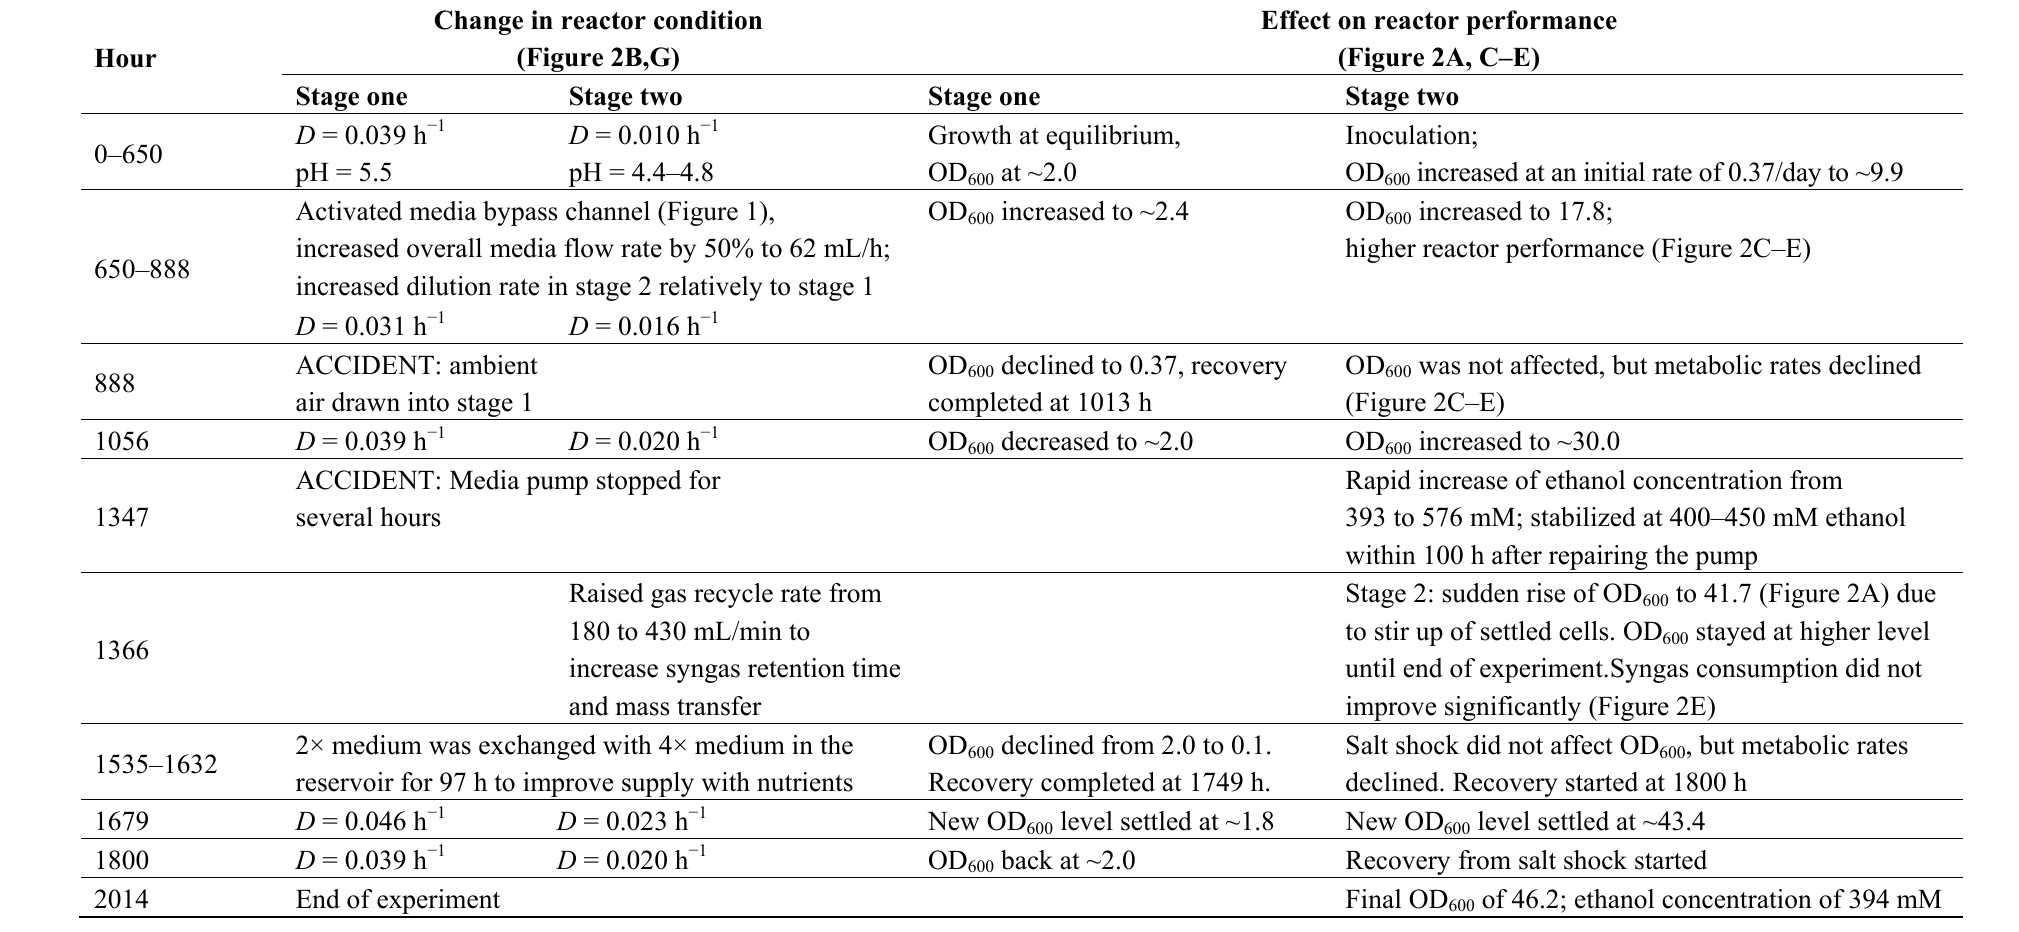
Table 1. Summary of changes in reactor operating conditions and their effect on reactor